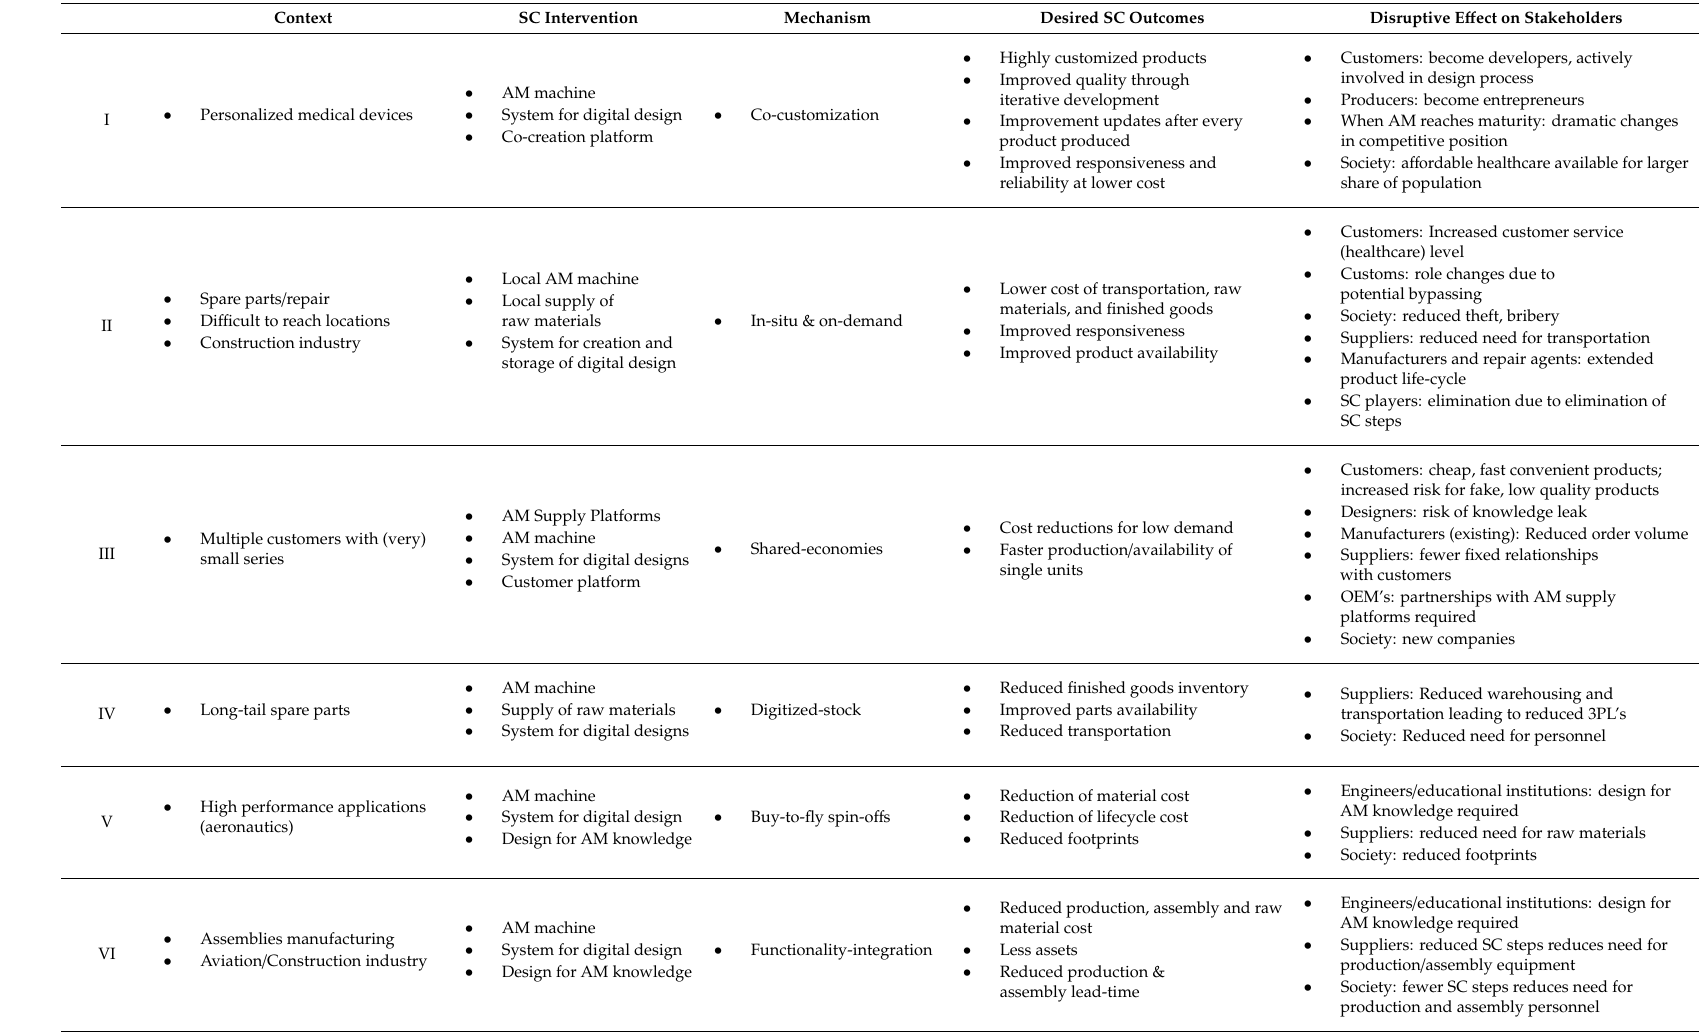
Table 3. CIMO per mechanism and disruptive e ff ects on SC